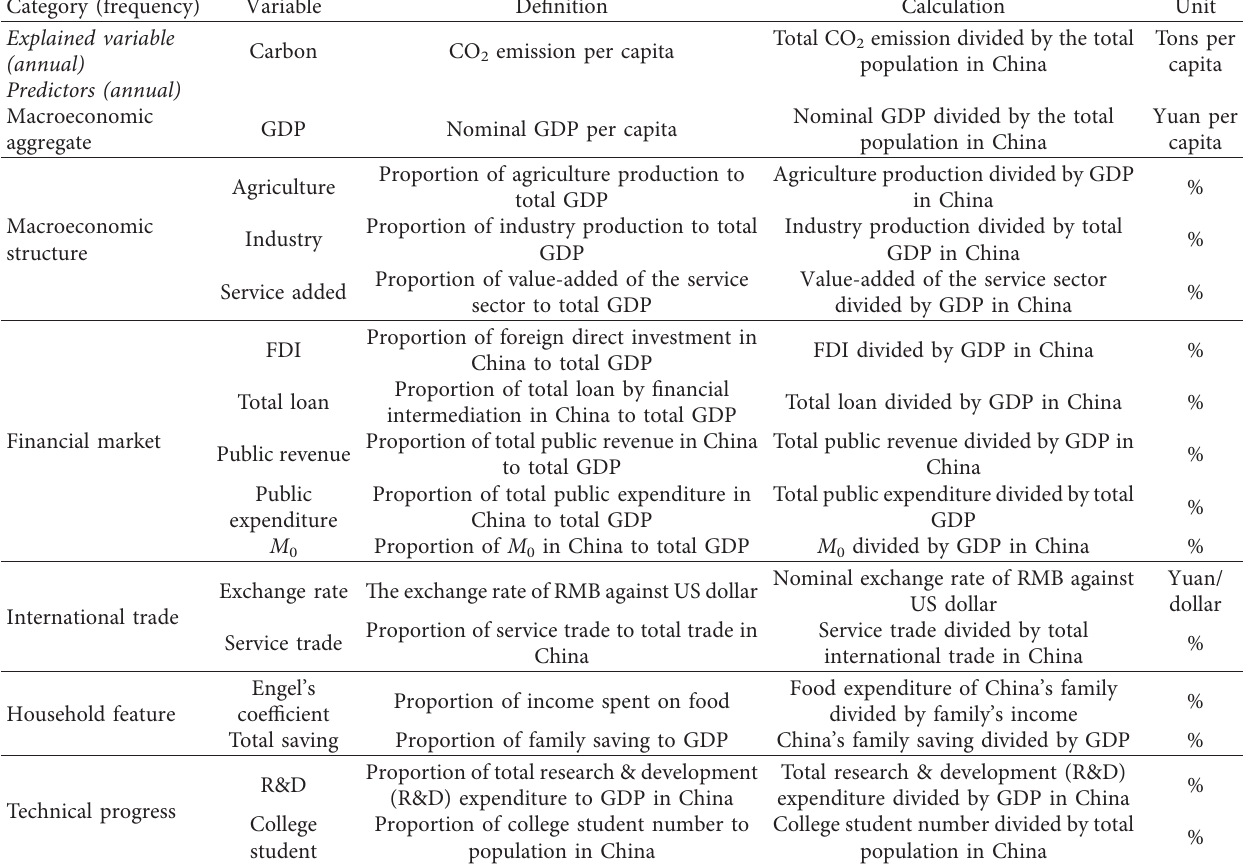
Table 1: Definitions of the explained variable and various nonenergy